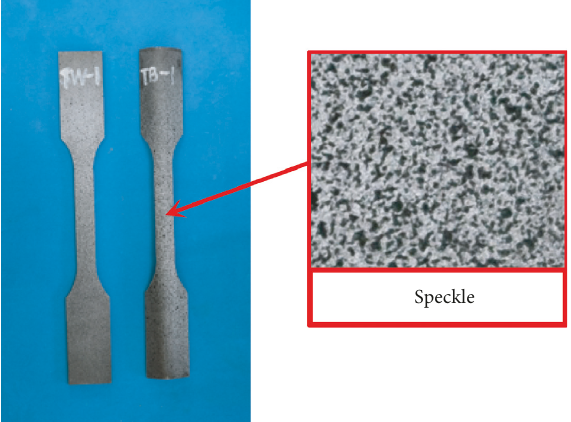
Figure 4: Speckle on coupon